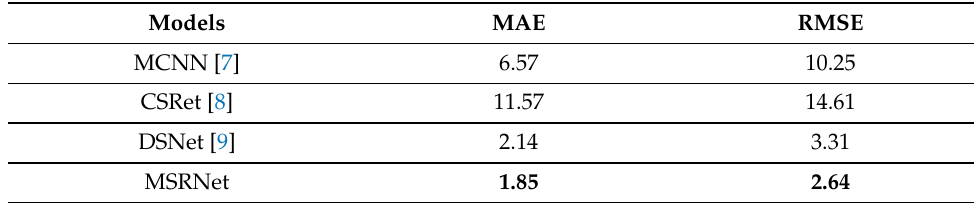
Table 2. Estimation errors on the cattle dataset.